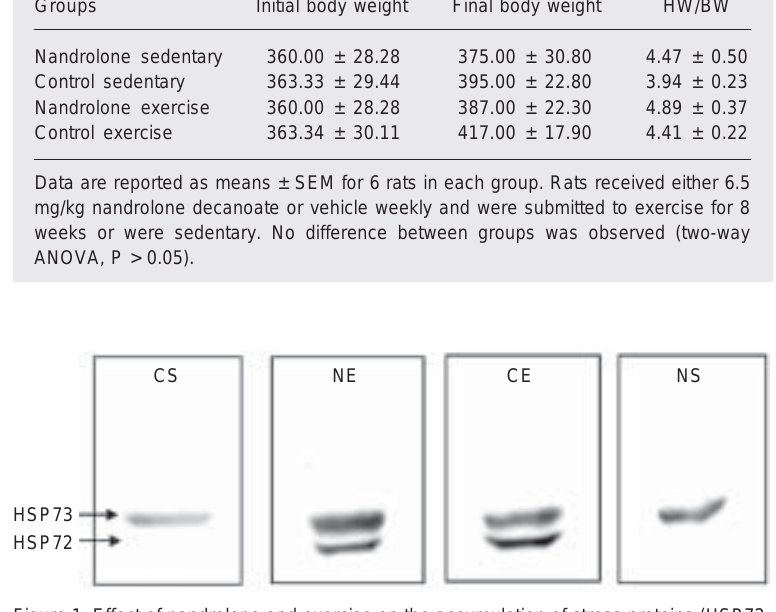
Figure 1. Effect of nandrolone and exercise on the accumulation of stress proteins (HSP72, HSP73) in the left ventricle of rats. Equal amounts of proteins from the left ventricle of rats from the four groups were separated by SDS-PAGE and immunoblotted with a monoclonal HSP70 antibody. The animals were treated as described in the legend to Table 1. NE = nandrolone exercise; CE = control exercise; NS = nandrolone sedentary; CS = control